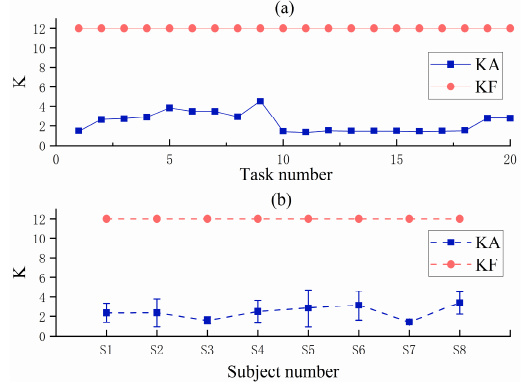
Figure 19. ( a ) Comparison of K values of S1 in different modes. ( b ) Comparison of K values of eight subjects in different modes.